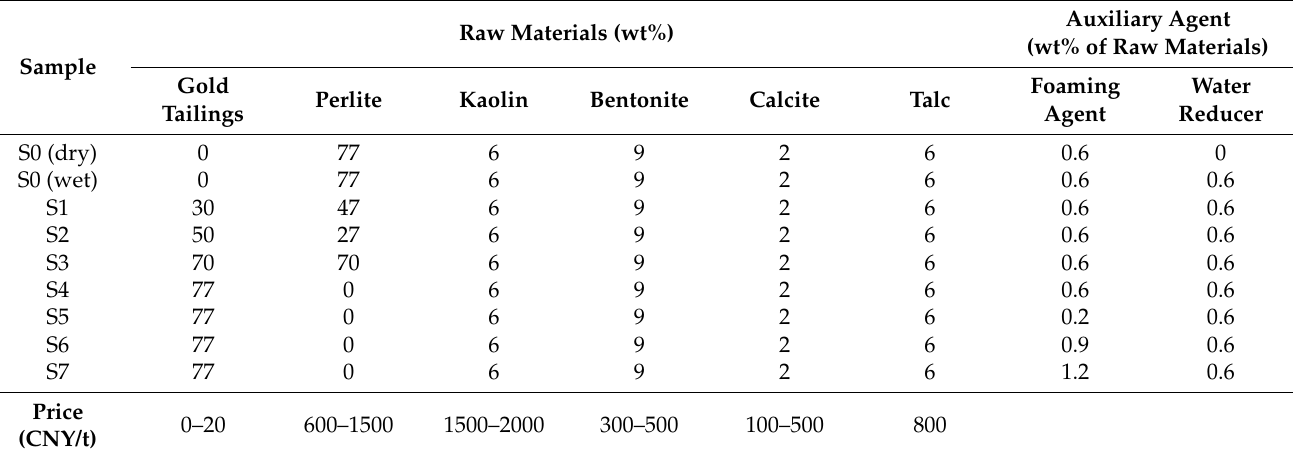
Table 1. Material composition of the foam ceramic